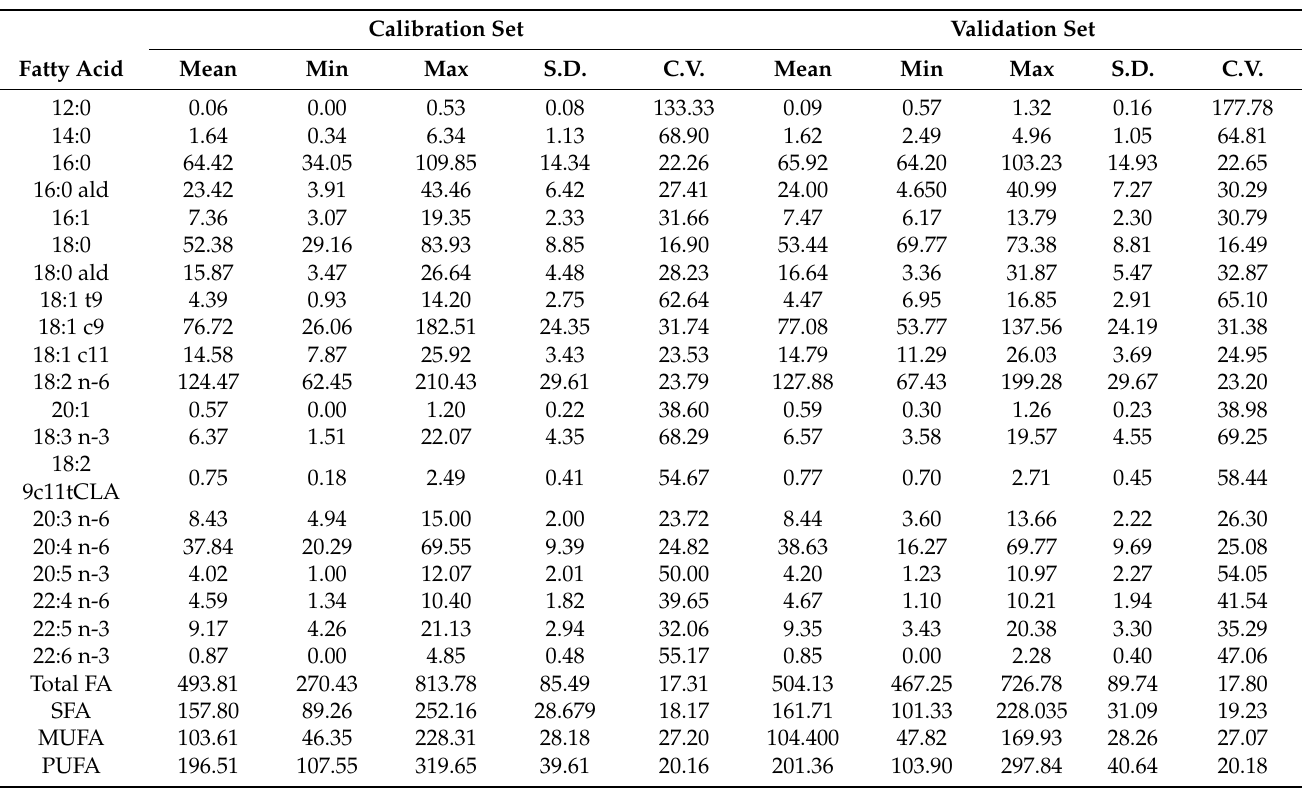
Table 1. Descriptive statistics of the phospholipid fraction of fatty acids (mg/100 g of meat) of calibration and validation sets. Calibration Set Validation Set